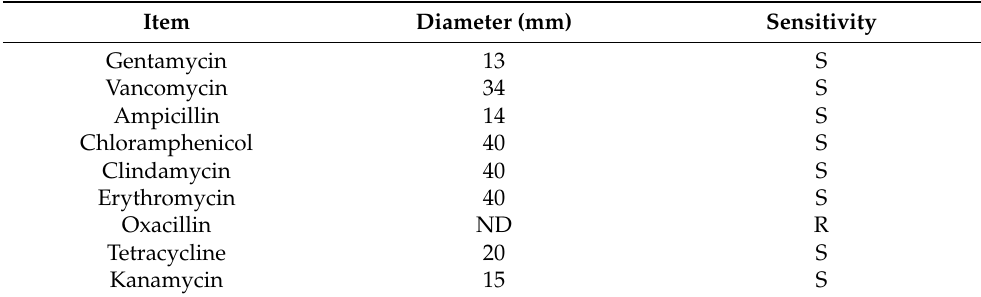
Table 2. Antibiotic susceptibility of P. konkukensis .